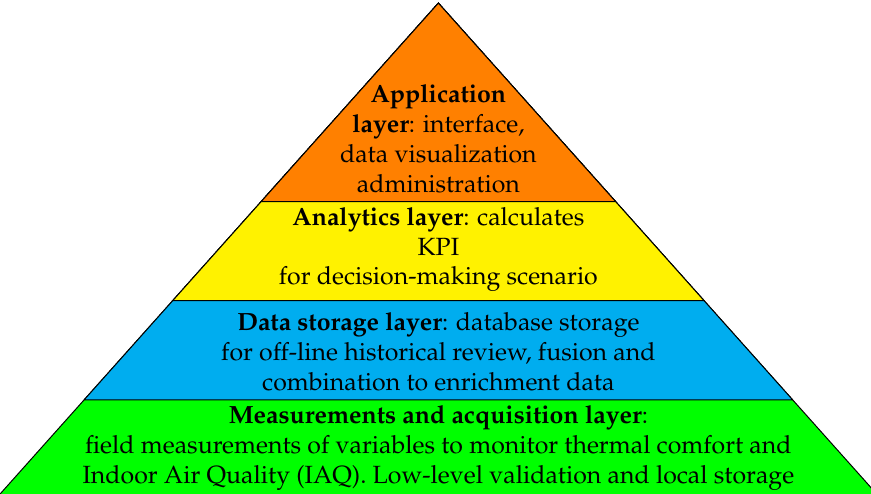
Figure 2. IoT platform as a hierarchical